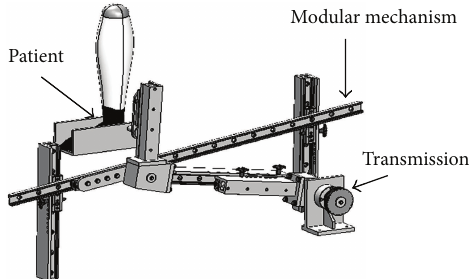
feedback signal strategy) providing an effective and robust